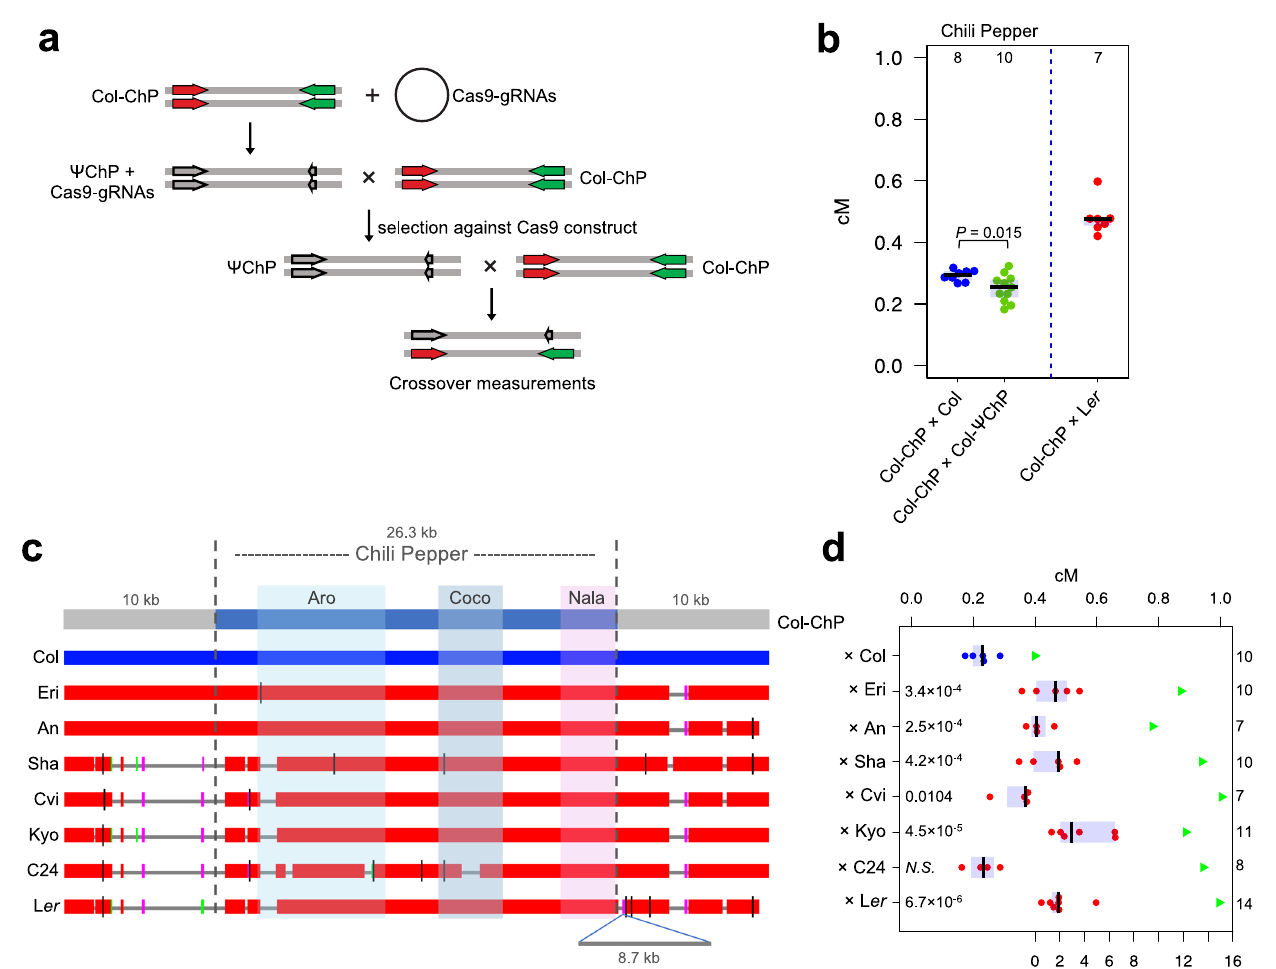
Fig. 3 | Effects of InDels and structural variation on CO frequency within the ChPinterval.a GenerationofCol-pseudo-ChP(Col- Ψ ChP).Cas9sgRNAswereused to simultaneously generate mutations in the dsRed and eGFP cassettes, leading to the loss of fl uorescence. Non fl uorescent seeds were sequenced and crossed with Col-ChPtomeasureCOfrequency. b COfrequencyforCol×Col-ChPandCol×Col- Ψ ChP. Measurements for Col-ChP × L er are shown for comparison. The center line of aboxplotindicatesthemean;theupperand lowerboundsindicatethe75thand 25th percentiles, respectively. Each dot represents a measurement from one indi- vidual. The number of individuals are also indicated above the boxplots. The two- sided P value was estimated by Welch ’ s t -test. c Alignments of the ChP region betweendifferentArabidopsisaccessions.Thebluehorizontalbarshowsthequery sequence (Col), red horizontal bars indicate homologous sequences in other